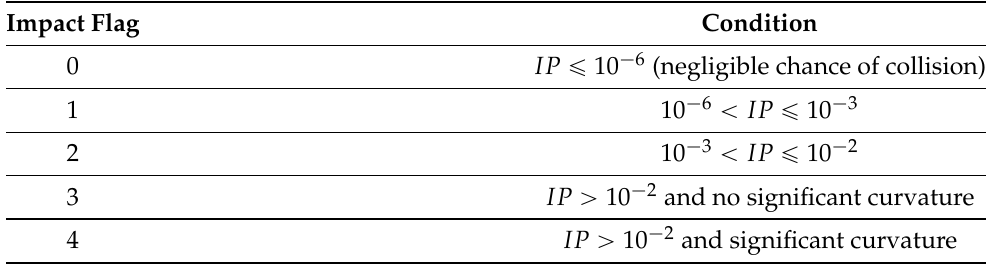
Table 1. Conditions on impact probability and curvature to assign the impact flag to an object, from [8]. Impact